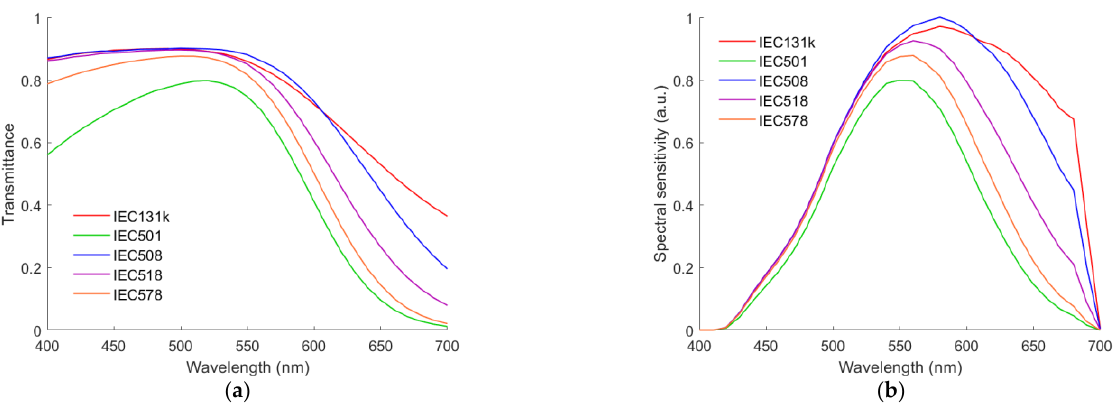
Figure 3. ( a ) Spectral transmittance of five compensation filters for camera sensors. ( b ) Spectral sensitivities of the yellowish green channels using the filters in ( a ).